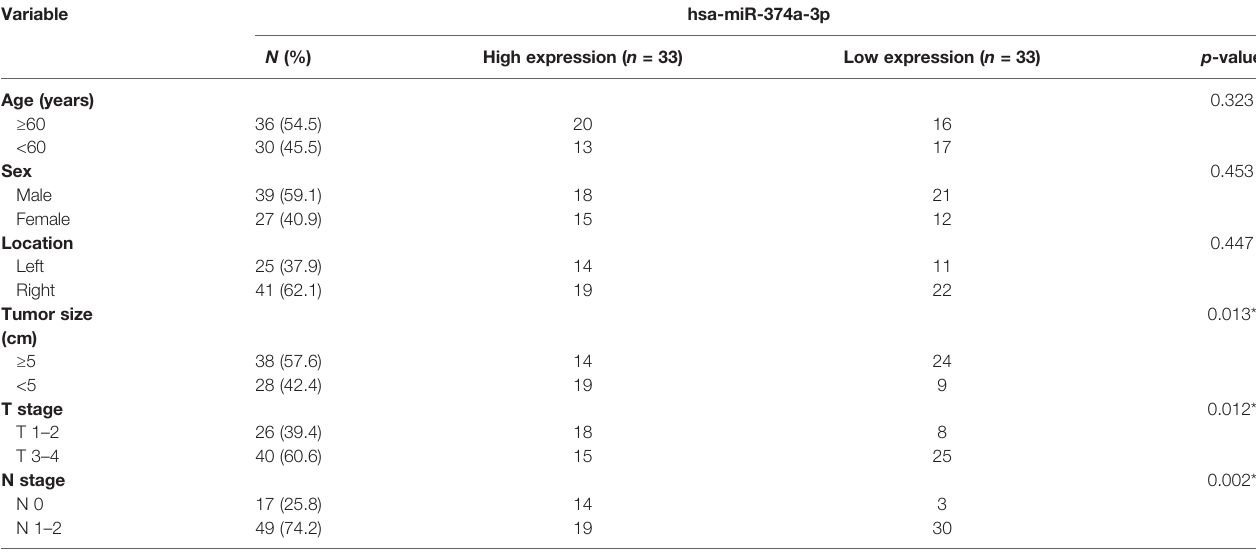
TABLE 3 | Relationship between clinical or pathological characteristics and hsa-miR-374a-3p levels. Variable